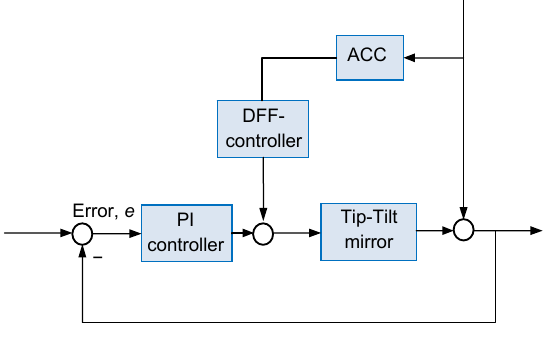
Fig. 3 | DFF control structure of Tip-Tilt